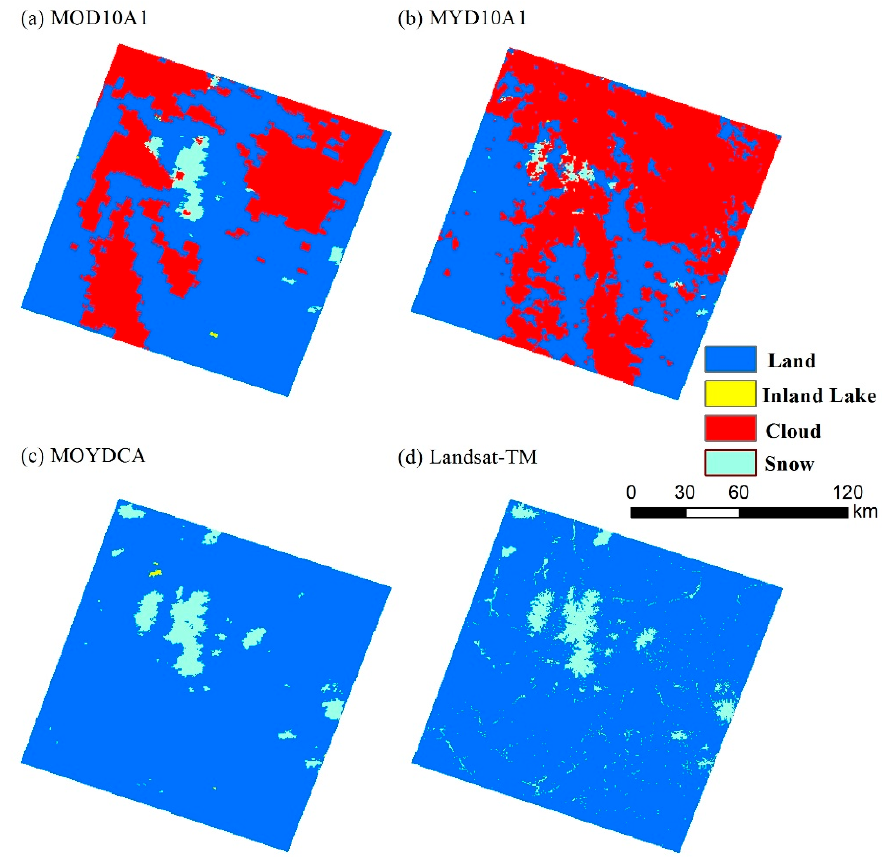
Figure 3. Examples of snow-cover maps from MODIS composites and Landsat-TM on 5 May 2007.